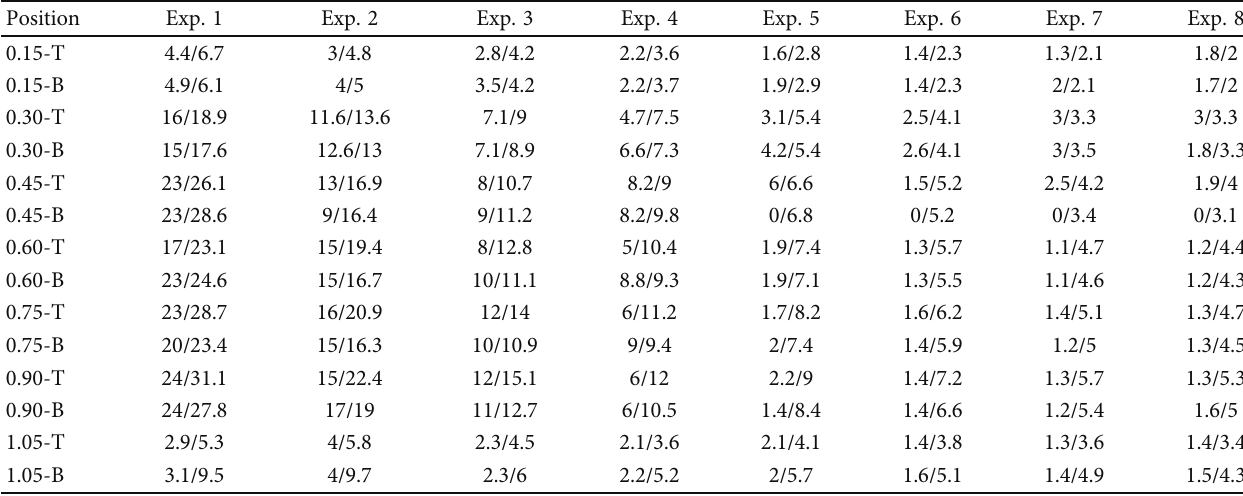
/ t data (unit: s). LFP CHF